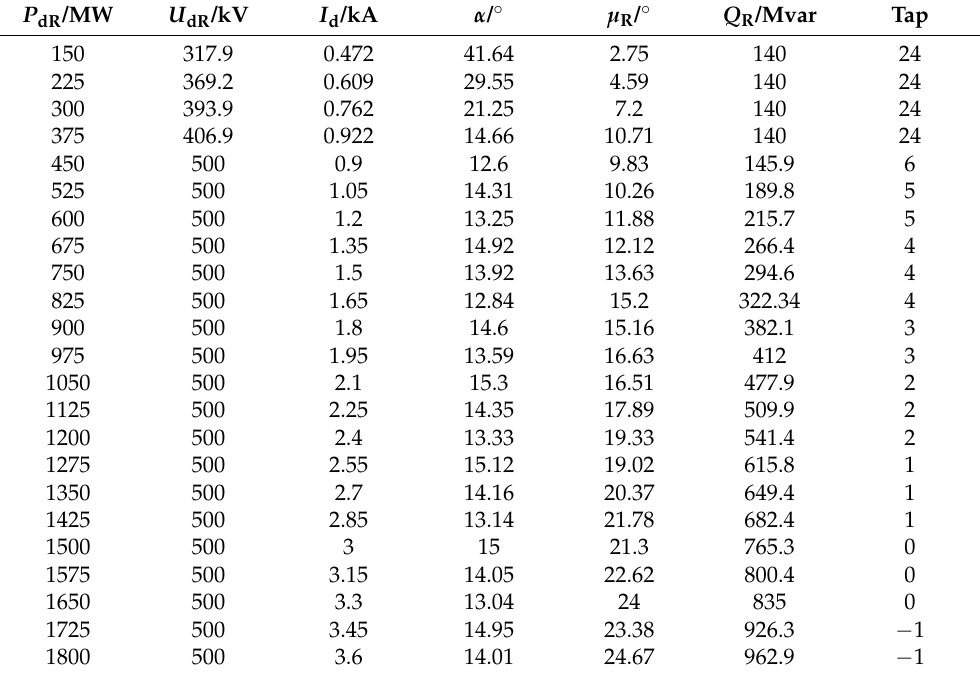
Table 6. Main circuit parameters at the rectifier side (data per pole).